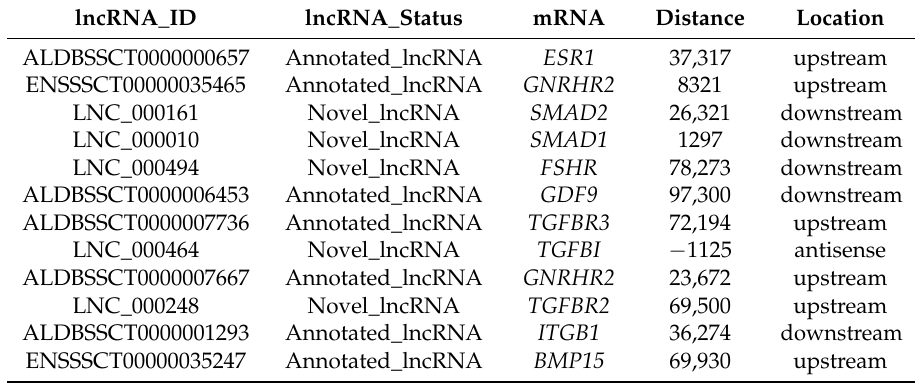
Table 2. Genomic association between lncRNAs and nearby reproductive-trait-related